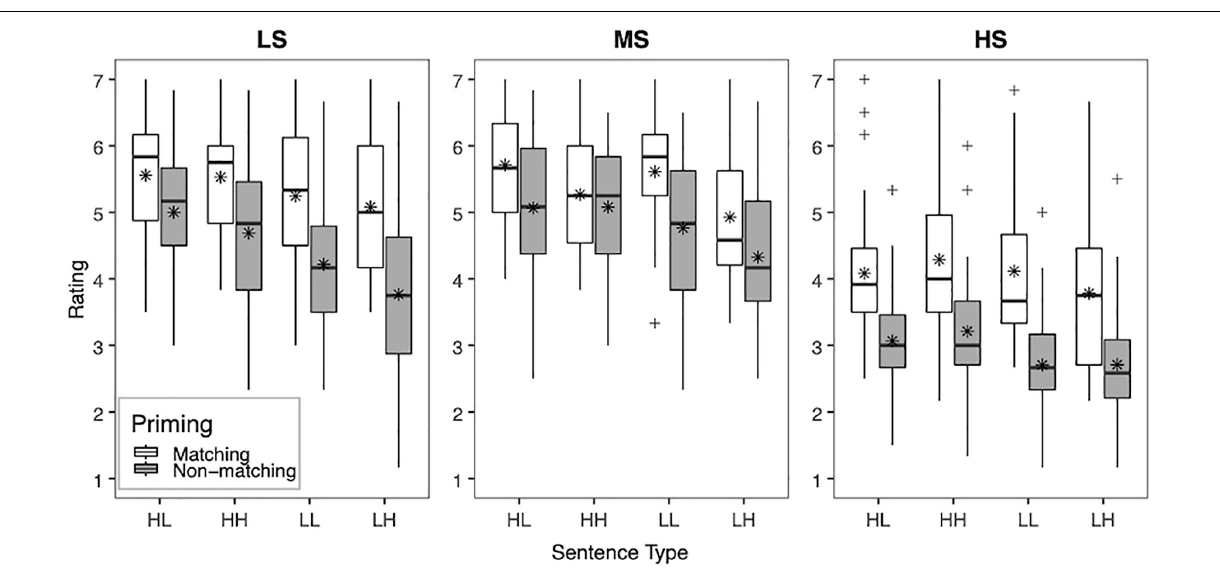
FIGURE 2 | Box plot showing the mean clarity ratings for NH older adults (ONH). Clarity ratings (1 “very unclear” to 7 “completely clear”) are plotted across all three vocoder conditions (LS, MS, and HS), priming condition (matching and non-matching), and sentence type (HL, HH, LL, and LH). The boxes extend from the lower to the upper quartile (the interquartile range, IQ), the solid midline indicates the median, and the star indicates the mean. The whiskers indicate the highest and lowest values no greater than 1.5 times the IQ, and the plus signs indicate outliers, which are defined as data points larger than 1.5 times the